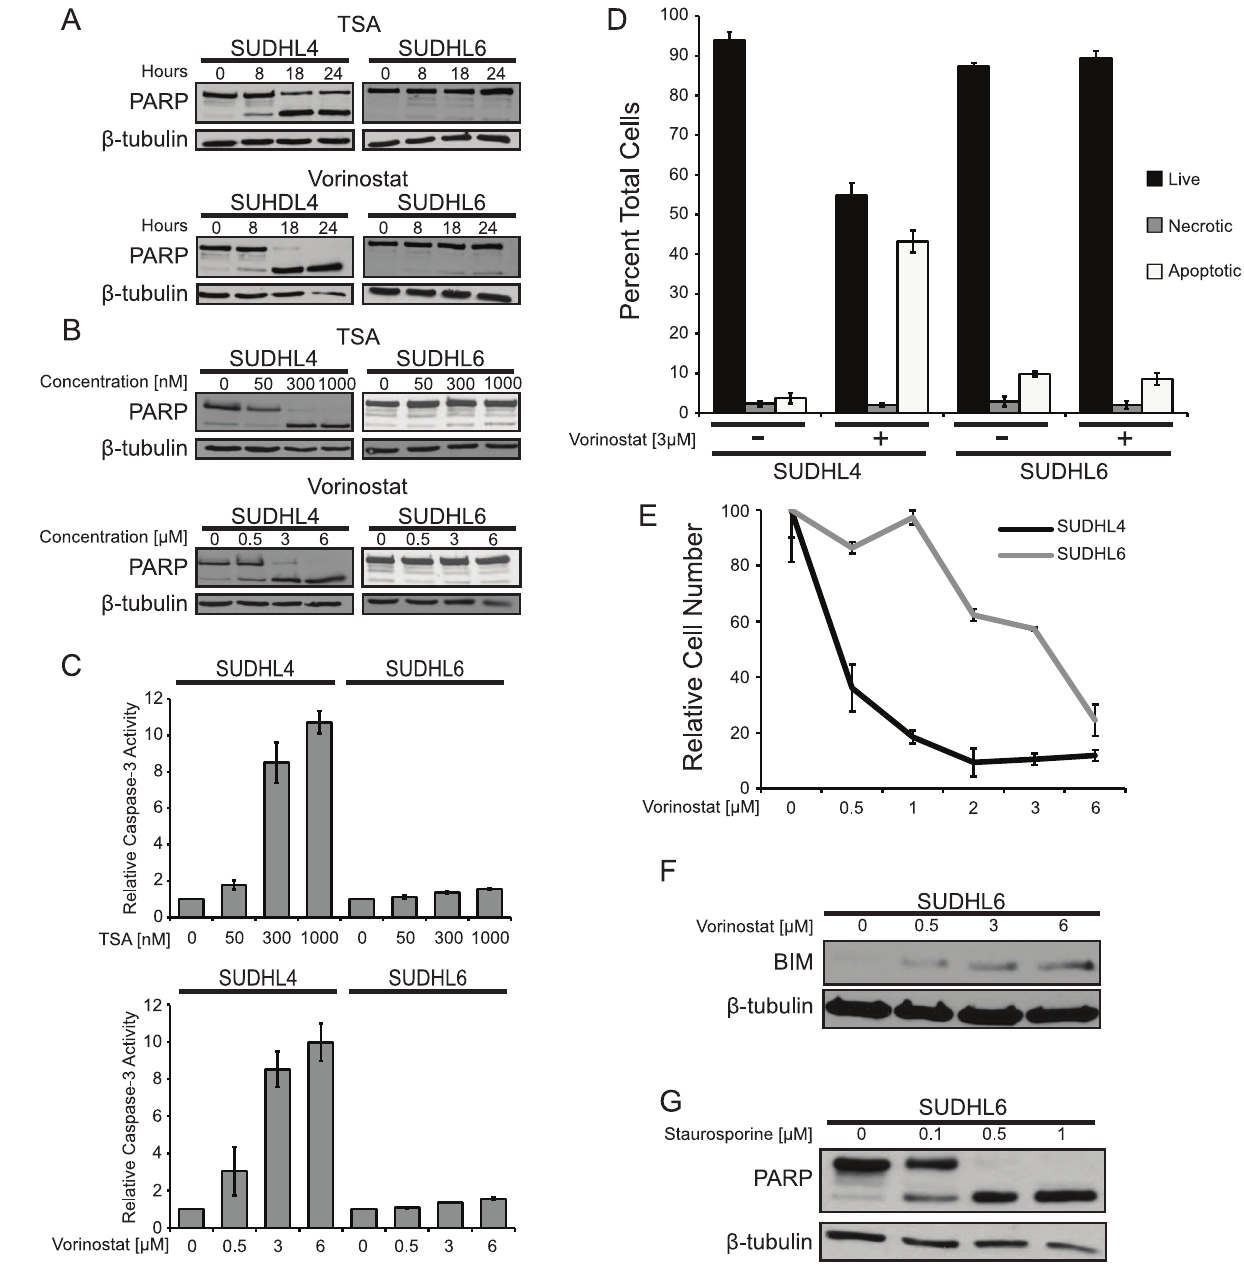
Figure 2. Trichostatin A and vorinostat induce apoptosis and inhibit growth in a time- and dose-dependent manner. ( A ) SUDHL4 and SUDHL6 cells were treated with either 300 nM TSA or 3 m M vorinostat for the indicated times. Whole-cell extracts were made, and Western blotting for PARP and b -tubulin (as a normalizing control) was performed. ( B ) SUDHL4 and SUDHL6 cells were treated for 14 h with the indicated concentrations of either TSA or vorinostat. PARP cleavage and b -tubulin levels (as a normalizing control) were assessed by Western blotting of whole- cell extracts. ( C ) Relative caspase-3 activity was measured in cells treated for 14 h with either TSA or vorinostat as indicated. The values represent the average relative fluorescence of three independent assays as compared to untreated samples (1.0). Error bars indicate standard error. ( D ) SUDHL4 and SUDHL6 cells were treated with 3 m M vorinostat for 14 h, cells were stained with acridine orange and ethidium bromide, and counted for live (black bars), necrotic (grey bars), and apoptotic (white bars) cells (see Materials and Methods). Each value is the average of three independent experiments and error bars indicate standard error. ( E ) Growth inhibition by vorinostat was assessed by treating SUDHL4 and SUDHL6 cells with increasing concentrations of vorinostat for 72 h, and cells were then counted using a hemocytometer. The relative numbers of cells are percentages as compared to cells grown for the same amount of time in the absence of vorinostat. The results are the averages of three separate treatment samples. Error bars indicate standard deviation. ( F ) SUDHL6 cells were treated with the indicated concentrations of vorinostat for 4 h. BIM and b -tubulin (as a normalizing control) were detected by Western blotting of whole-cell extracts. ( G ) SUDHL6 cells were treated for 24 h with the indicated concentrations of staurosporine. PARP cleavage and b -tubulin (as a normalizing control) were assessed by Western blotting of whole-cell extracts.